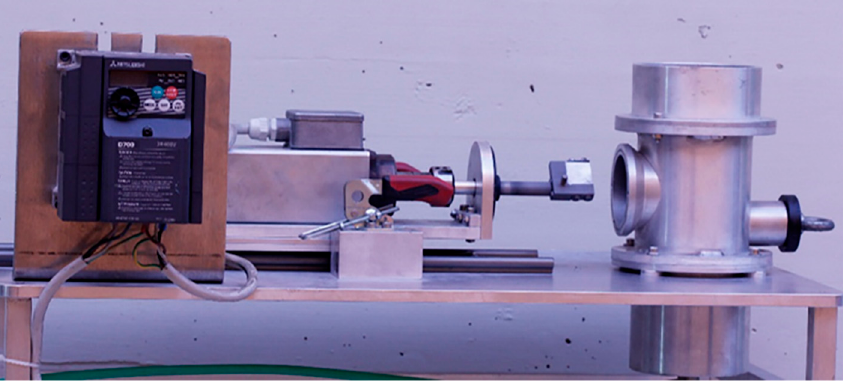
Figure 1. FB device exploited for the Al 2 O 3 coating on magnesium substrate